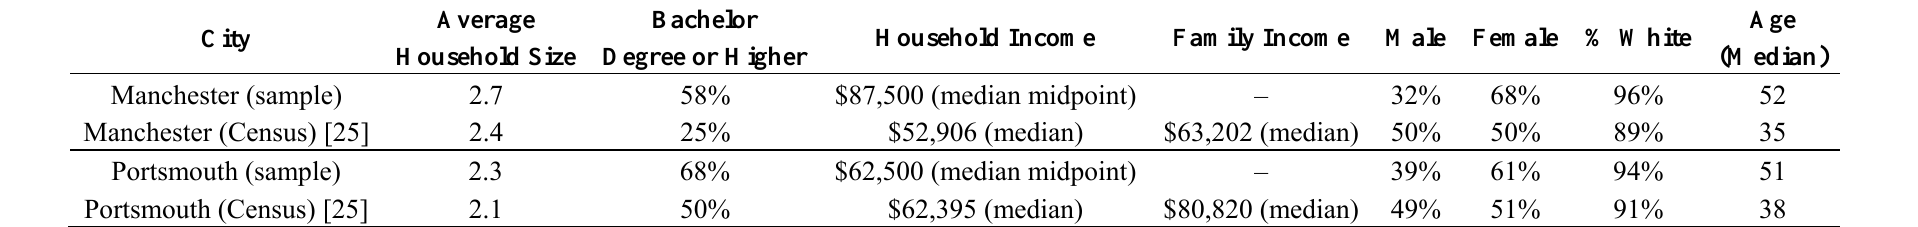
Table 1. Census and sample demographics.